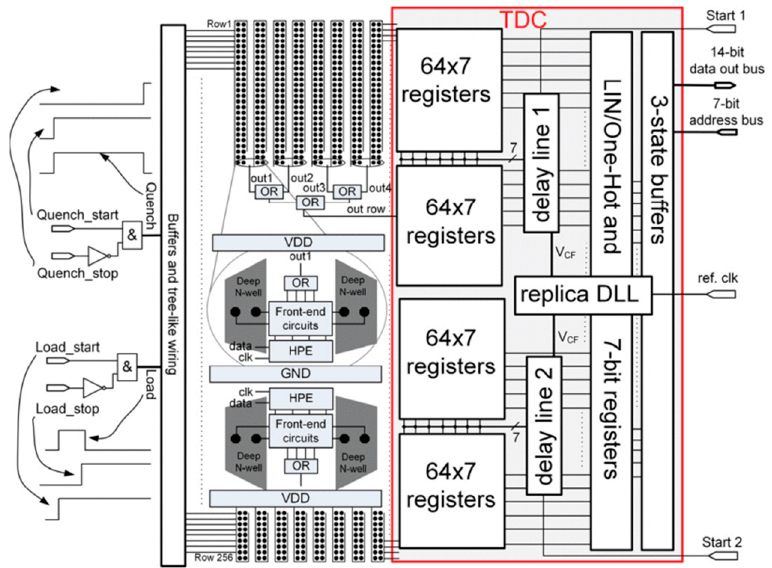
Figure 12. Block diagram of the time-gated 16 × 256 SPAD line sensor with on-chip 256-channel TDC [73]. TDC